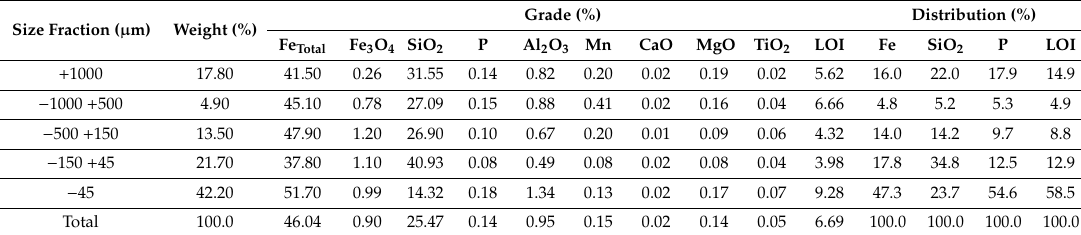
Table 1. Chemical composition and loss on ignition (LOI) by size fraction of the run of mine (ROM) of the amphibolitic itabirite